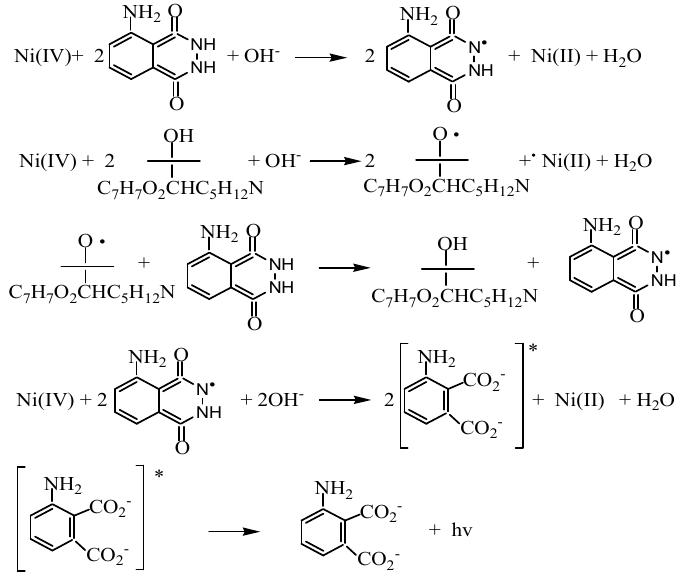
Figure S1: Effect of Ni(IV) concentrations on CL intensity; Figure S2: Effect of [OH − ] in Ni(IV) solutions on CL intensity; Figure S3: Effect of luminol concentrations on CL intensity; Figure S4: Effect of [OH − ] in luminol solutiosn on CL